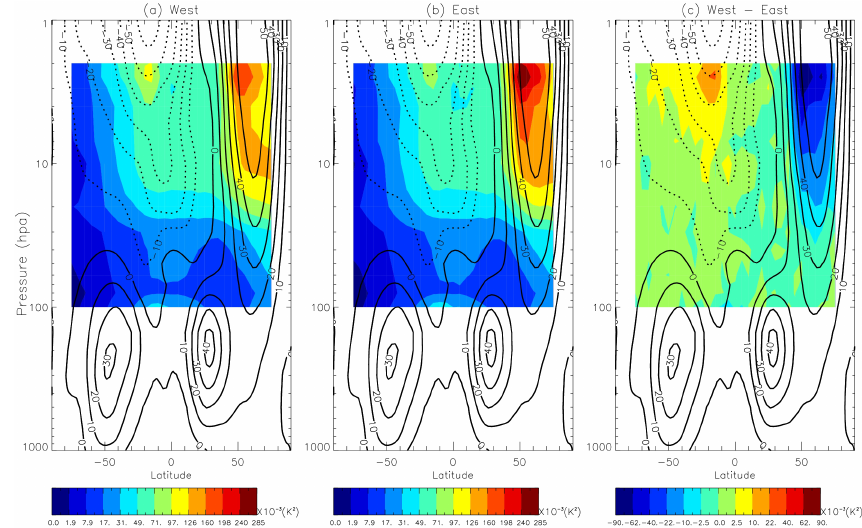
Fig. 3. Zonal mean of the GW variance at the westmost view (a) , eastmost view (b) and the difference between the westmost and eastmost views (c) as a function of latitude and height for January, 2005. Monthly mean zonal winds obtained from UK Met Office are contoured in solid (westerly) and dotted (easterly) lines with an interval of 10ms − 1 . The color scale is linear by taking a square-root of the values. In (c) , positive (negative) values correspond to preferred eastward (westward) propagation direction.